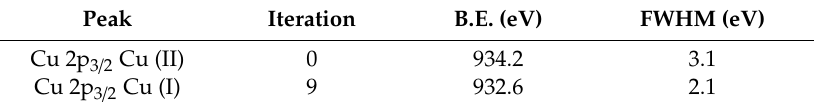
Table 8. Cu2p 3 / 2 fit parameters (referenced to adventitious carbon C1s peak at 285.1 eV). Figure 9. Copper sample degradation ( a ) and fit of the initial narrow scan ( b ). Table 8. Cu2p 3/2 fit parameters (referenced to adventitious carbon C1s peak at 285.1 eV).